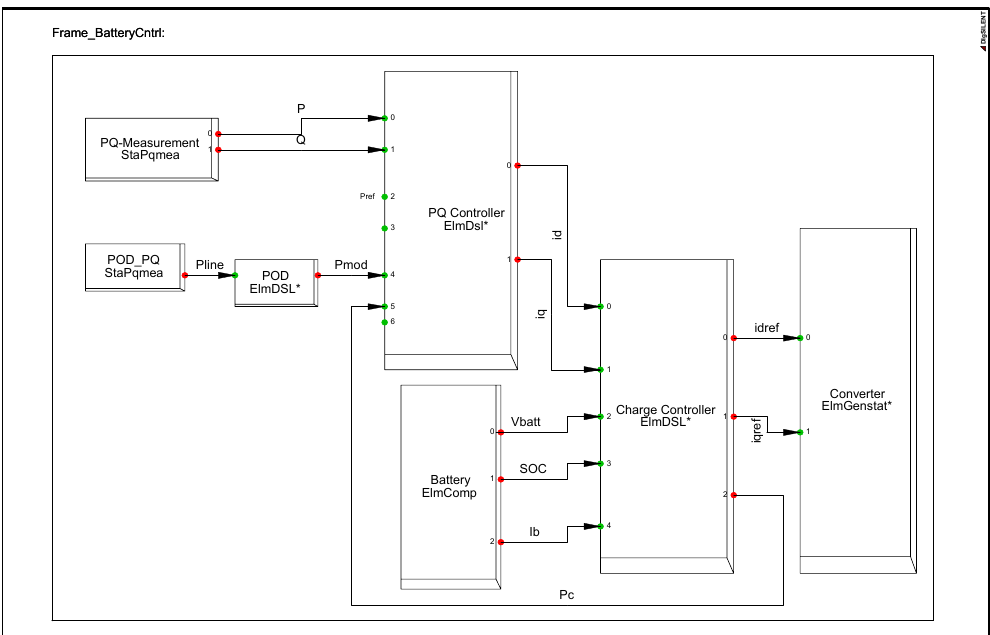
Figure 6. Developed model of NaS-based BESS with controllers in DIGSILENT.